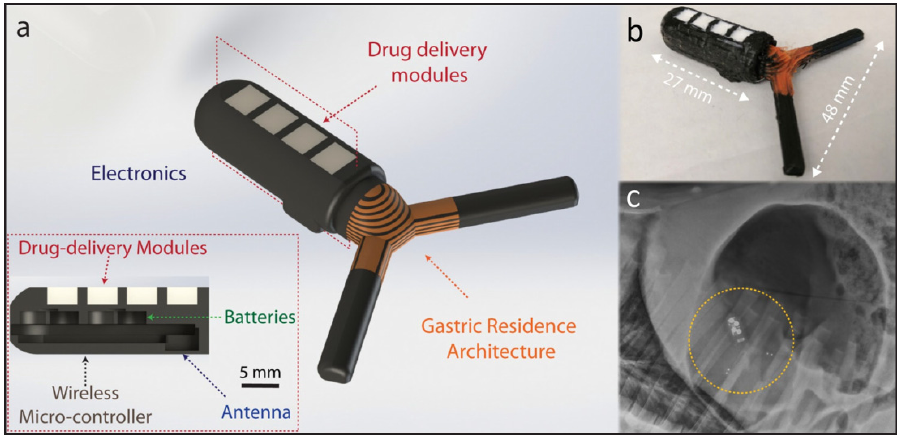
Figure 7. ( a ) 3D models of GRE device components, such as the gastric resident architecture, per- sonalized drug delivery modules, electronics and power system for communications and control. ( b ) Optical photograph of the 3D-printed GRE. ( c ) X-ray image of the deployed GRE in a porcine stomach. Reproduced with the permission of Reference [24]. Copyright National Science Founda- tion.